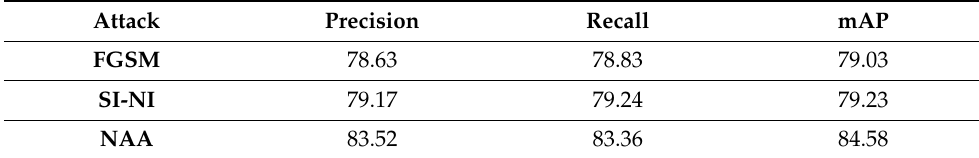
Table 5. Defence training verification test